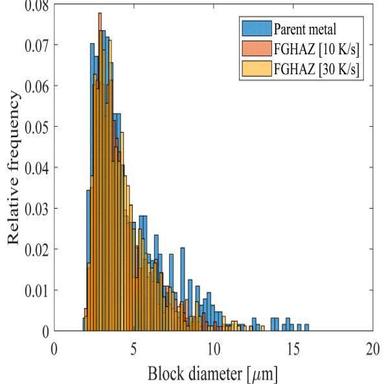
Measured block diameter distributions in X100Q PM, FGHAZ (10 K/s), and FGHAZ (30 K/s) from EBSD data.